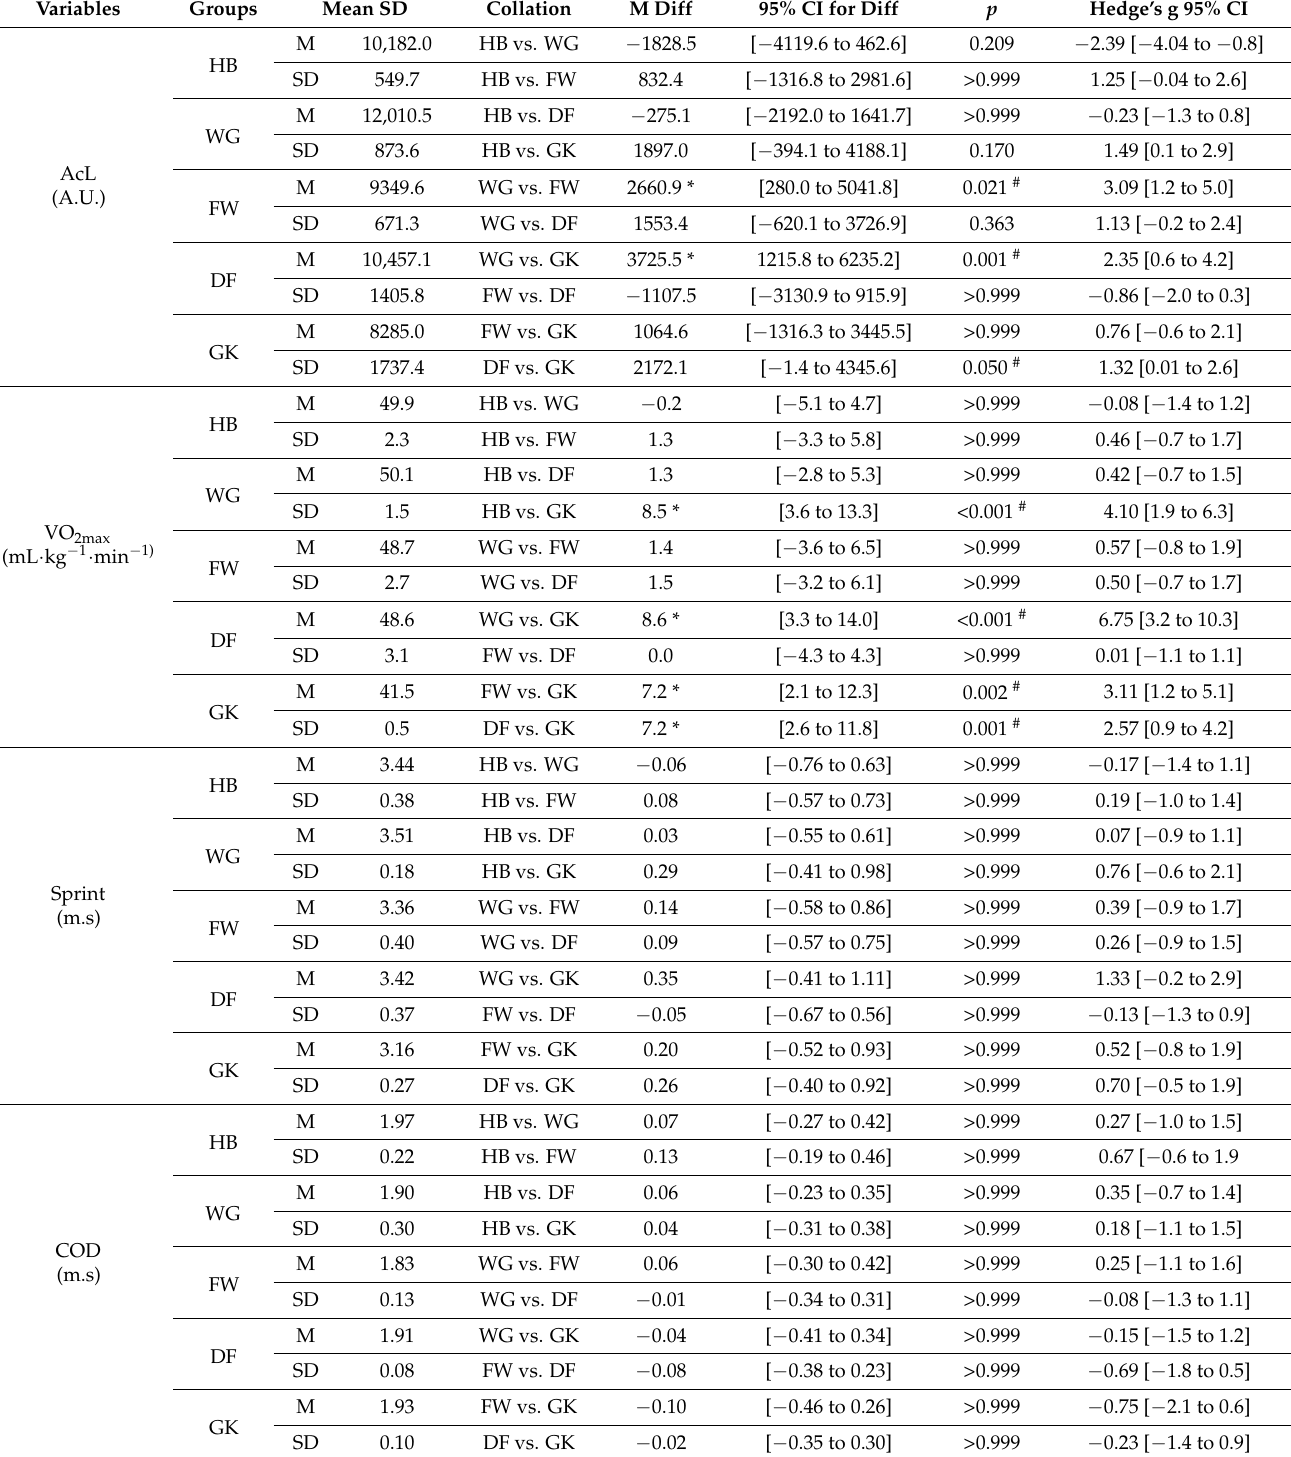
Table 2. Between-group comparisons for accumulated load and fitness parameters between playing positions in pre-season. Variables Groups Mean SD Collation M Diff Hedge’s g 95% CI